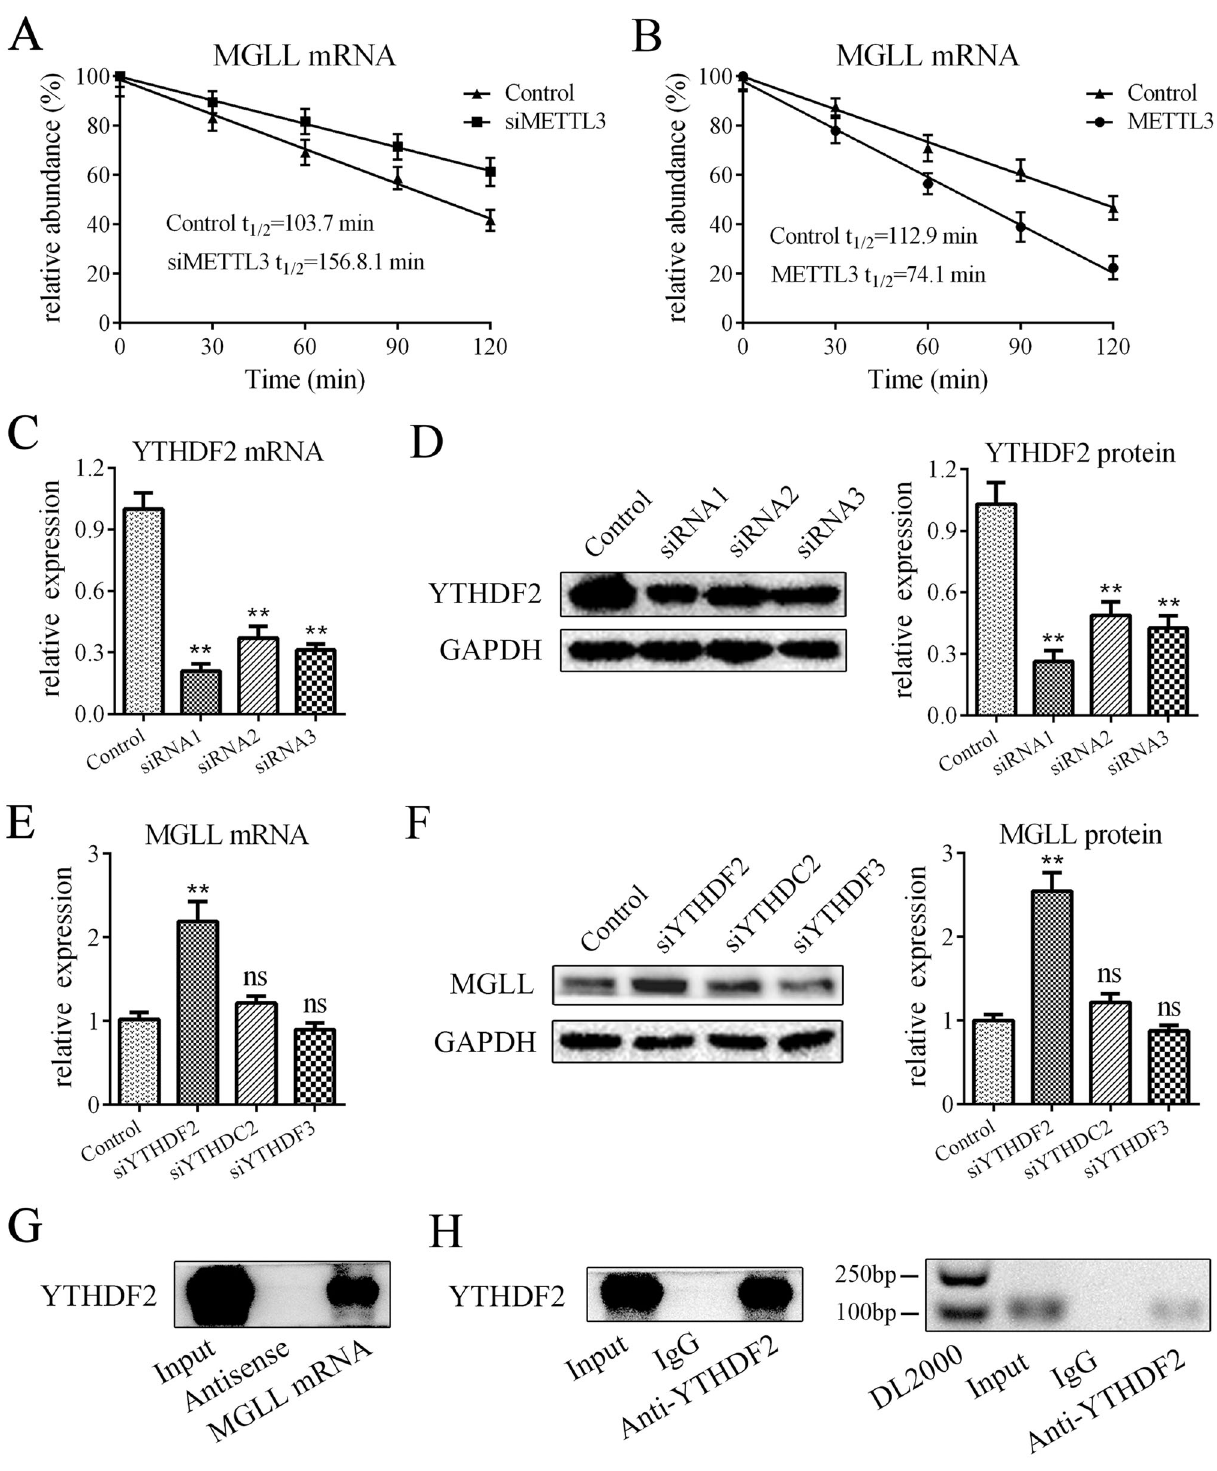
Fig. 5 METTL3 accelerated the degradation of MGLL mRNA via YTHDF2. A METTL3 downregulation increased the half-life of MGLL mRNA. B METTL3 overexpression reduced the half-life of MGLL mRNA. C , D The mRNA and protein levels of YTHDF2 in adipocytes transfected with siRNAs. E , F The mRNA and protein levels of MGLL in adipocytes transfected with siRNAs targeting for YTHDF2, YTHDC2 or YTHDF3. G RNA pulldown showed that the YTHDF2 protein was interacted with MGLL mRNA but not antisense RNA. H RIP assay showed that MGLL mRNA was precipitated by YTHDF2 protein but not control IgG; n = 9, ** P < 0.01, ns indicates not signi fi cant. Control means treatment of negative control siRNA in A , C , D - F and means treatment of negative control lentivirus in B .